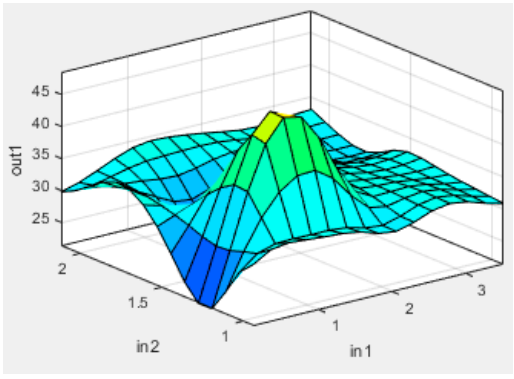
Figure 10. Surface plot of out1 (THR), in2 (sample mass) and in1 (heating rate).